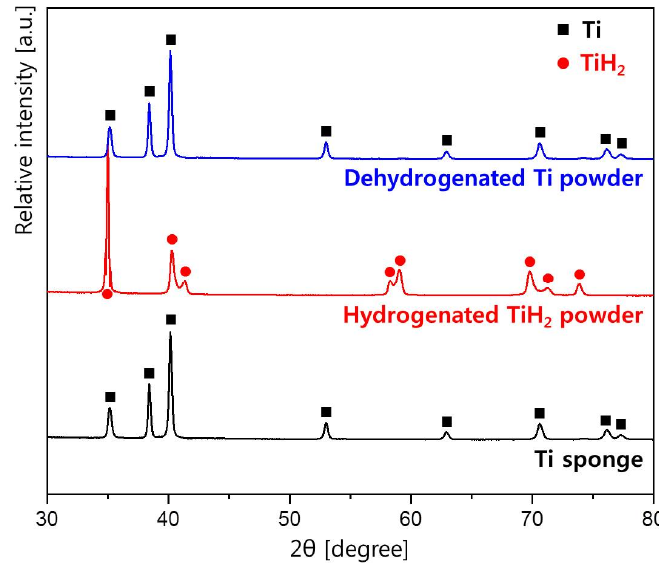
Figure 2. XRD patterns of the initial Ti sponge, the hydrogenated TiH 2 powder, and dehydrogenated Ti powder in the 2 θ range from 30 ◦ to 80 ◦ .